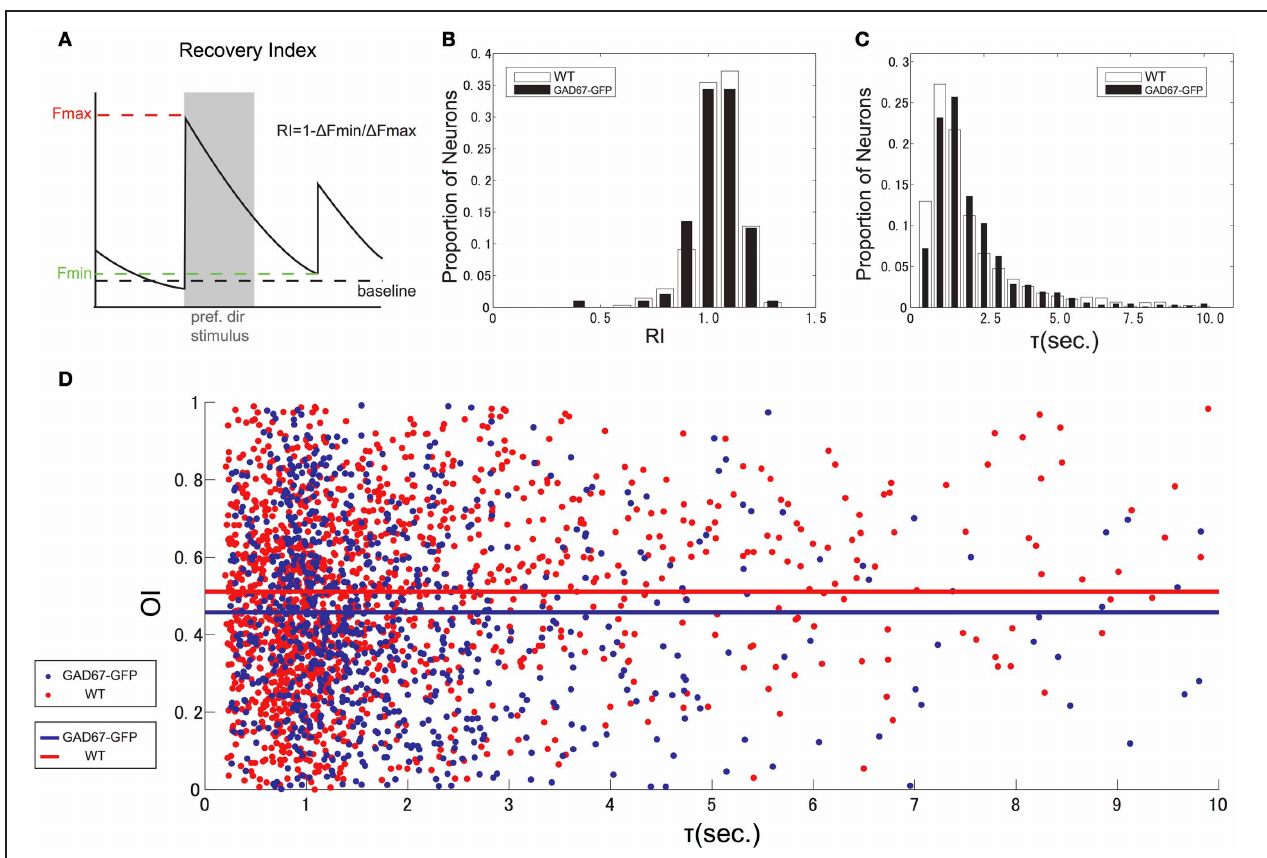
in non-stimulus period with exponential function. (D) Scatter plot and regression line of the relationship between tau and orientation selectivity for all responsive neurons from GAD-67GFP mice (blue) and WT mice